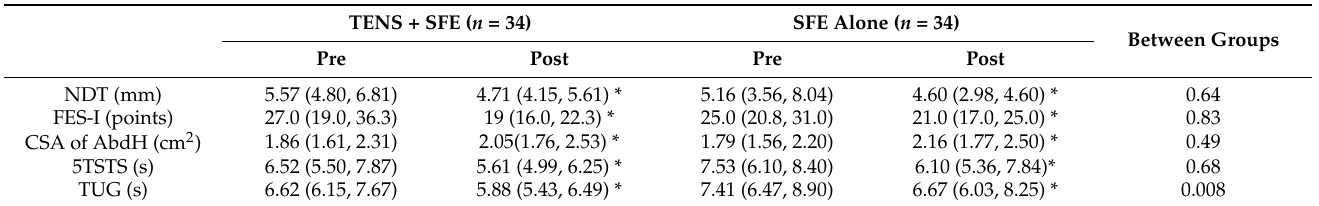
Table 2. Median and interquartile range of outcome measures before and after 4 weeks TENS combined SFE and SFE alone ( n =